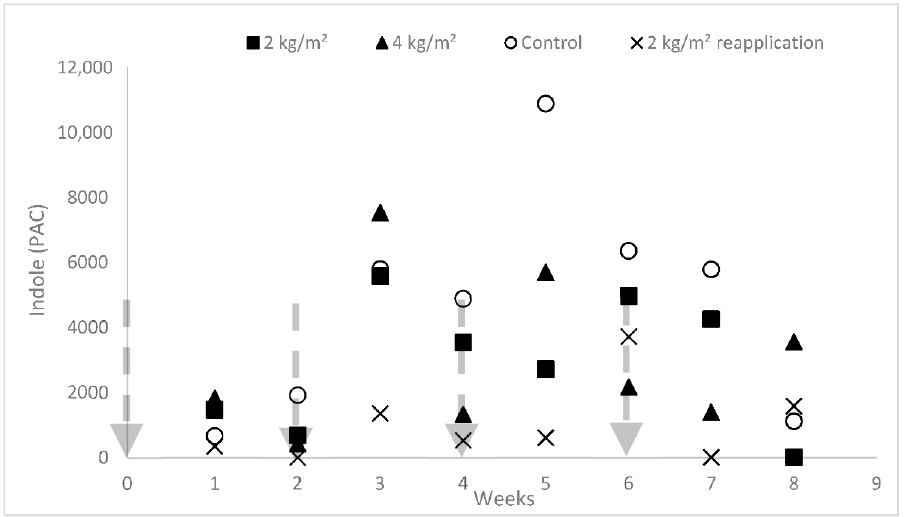
Figure 3. Mitigation of indole emissions from swine manure treated with biochar—effects of one-time dose (2 and 4 kg/m 2 ) and 2 kg/m 2 bi-weekly reapplication. Vertical arrows represent the application or reapplication of biochar and manure to storage simulators. Each data point represents the mean of ( n = 3) measurements. Detailed statistical analysis is provided in Table S3. A surrogate abundance of indole is represented by (PAC), i.e., peak area counts for indole in the headspace above manure measured by solid-phase microextraction (SPME) and analyzed by GC-MS. PACs are arbitrary units of an MS detector response.